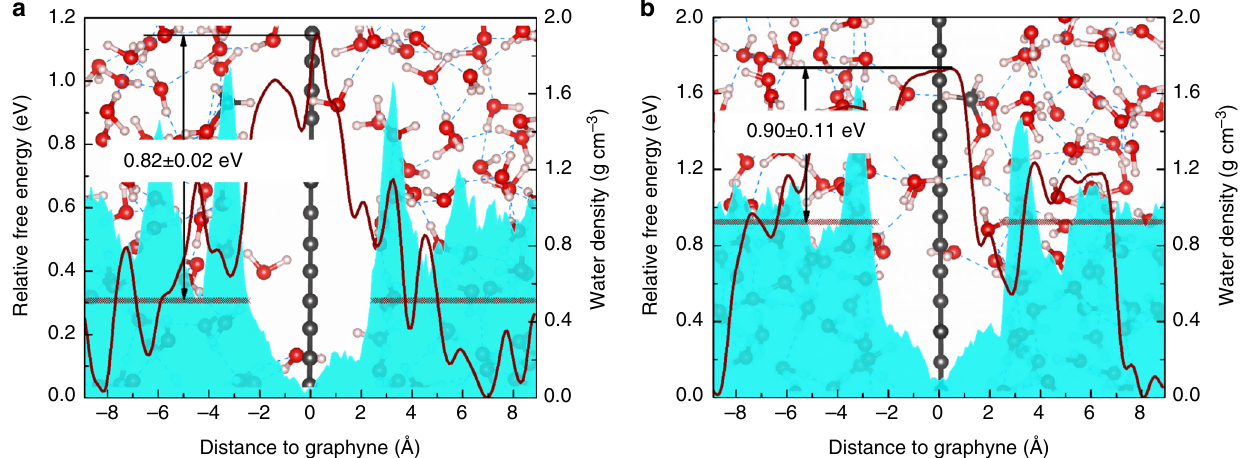
Fig. 6 Free energy pro fi les of methanol and density pro fi les of water. a graphyne ( n = 3) b graphyne ( n = 4). The background shows the initial geometries of the simulation